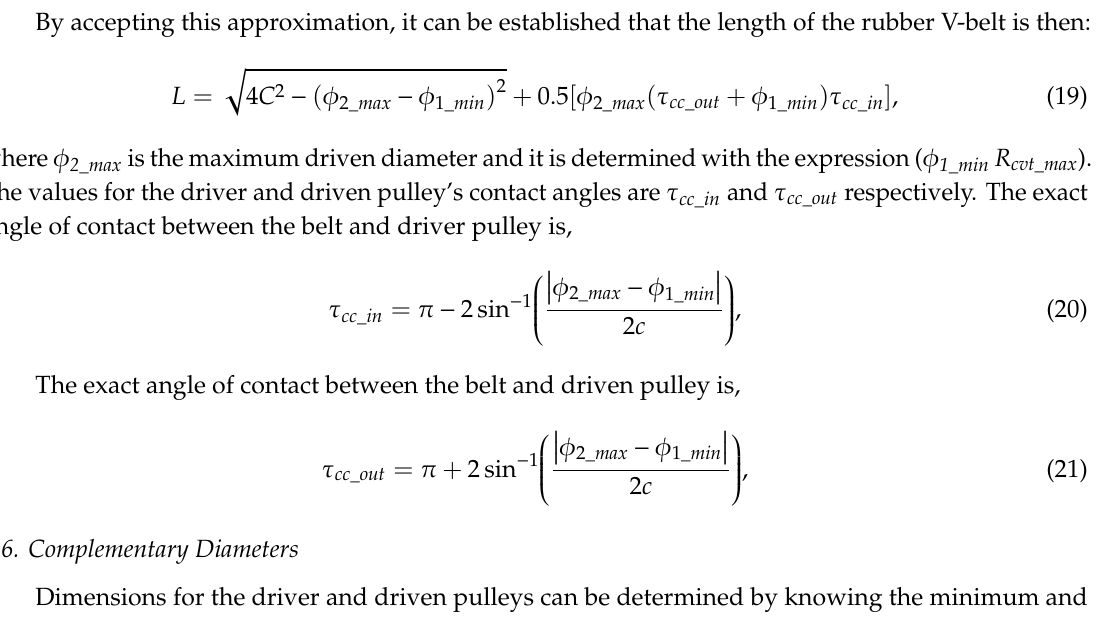
Figure 4. Distance between centers and τ cc .